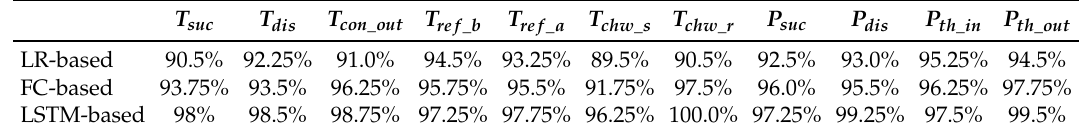
Table 8. Fault diagnosis ratios with positive bias.